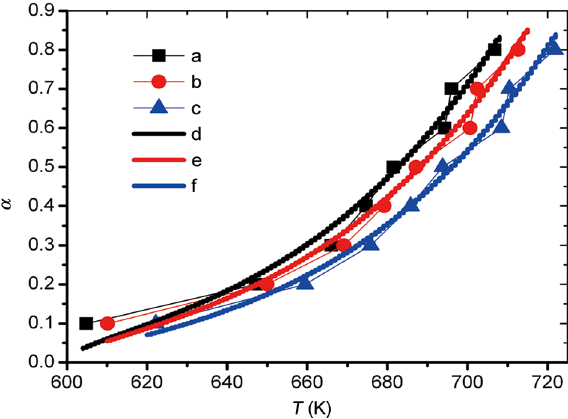
Figure 6 Curves of α versus T for experiment data: (A) 10, (B) 15, (C) 20 K min -1 and calculation results: (D) 10, (E) 15, (F) 20 K min -1